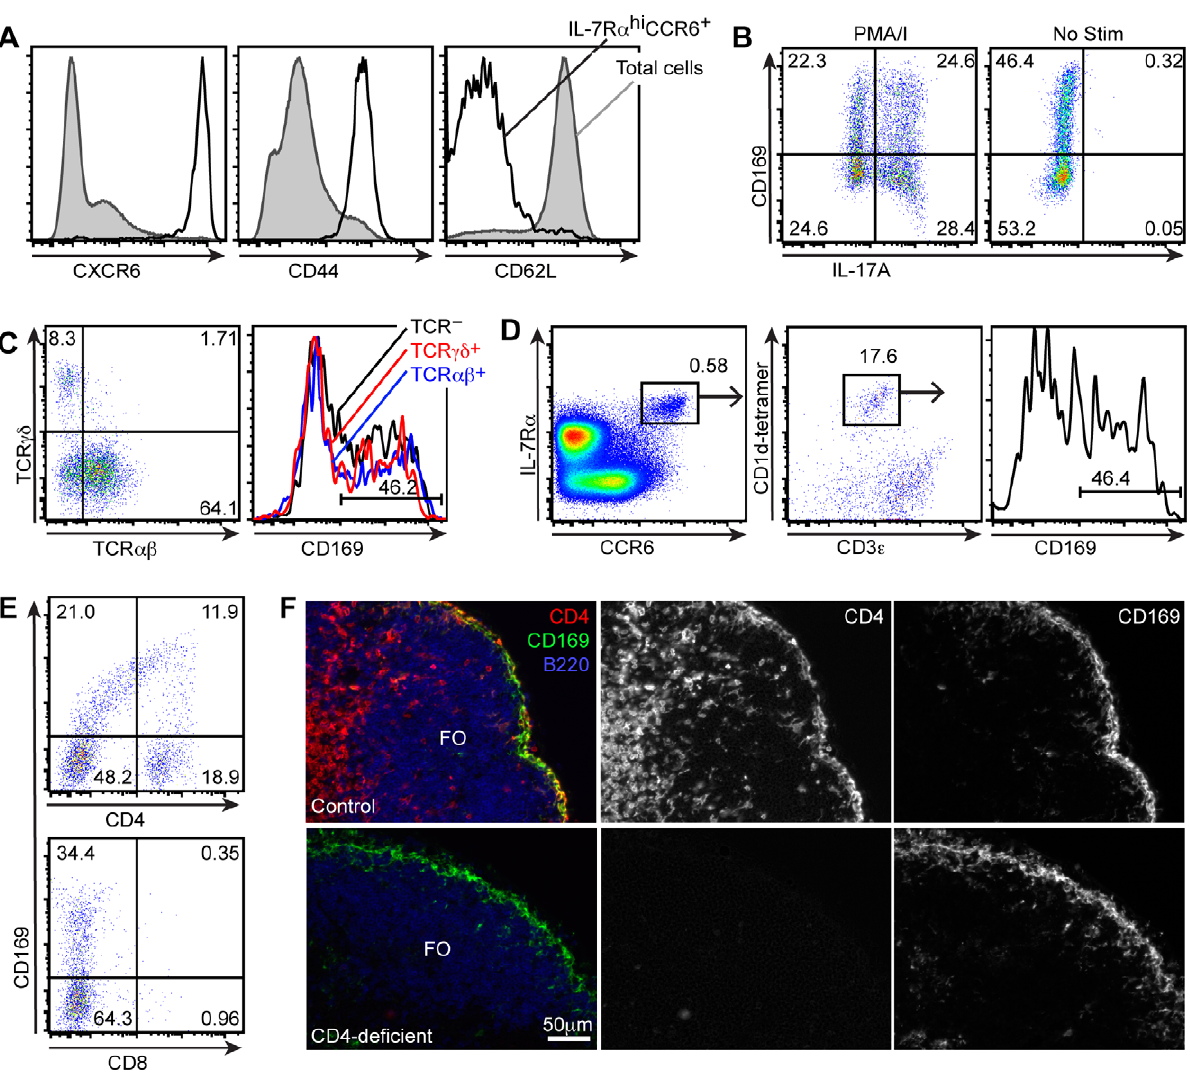
Figure 5. IL-7R a hi CCR6 + lymphocytes are IL-17 producing cells. (A) CD44, CD62L and CXCR6 expression on digested lymph node cells from control or Cxcr6 GFP/ + mice, gated on IL-7R a hi CCR6 + cells. (B) IL-17A staining of digested lymph node cells, stimulated with PMA/I for 2 h, gated on gated on IL-7R a hi CCR6 + cells. (C) ab T and cd T staining on digested lymph node cells, gated on IL-7R a hi CCR6 + cells; CD169 staining of ab T + , cd T + and TCR 2 IL-7R a hi CCR6 + cells gated as indicated in the left panel. (D) Flow cytometric detection of IL-7R a hi CCR6 + cells that bind CD1d-tetramers; far right panel shows CD169 staining on CD1d-tetramer + IL-7R a hi CCR6 + cells. (E) CD169, CD4, and CD8 staining on digested lymph node cells, gated on IL- 7R a hi CCR6 + cells. (F) Immunofluorescence microscopy of a lymph node from a wild-type or a CD4-deficient mouse, stained with anti-CD169 and anti- CD4 monoclonal antibodies. FO, follicle; T, T zone. Scale bar=50 m m. All data are representative of at least two independent experiments.